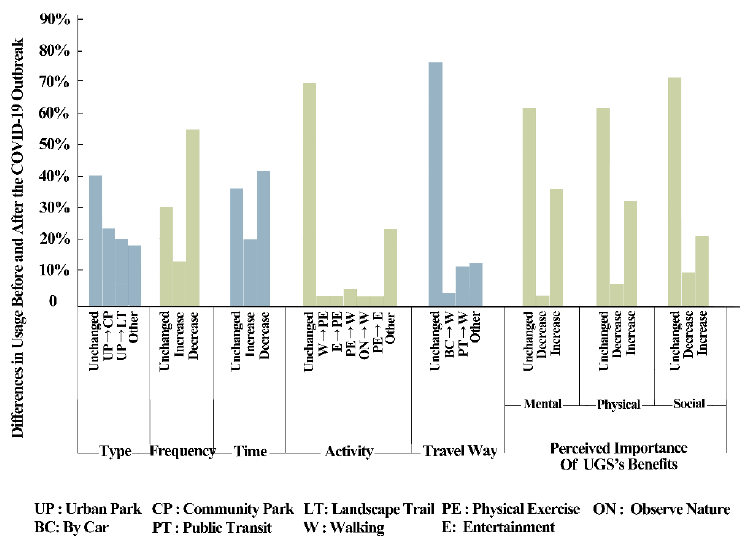
Figure 2. Percentage of variation in the type, frequency, duration, activity, means of travel and perceived importance of health benefits during the lockdown relative to before the pandemic.